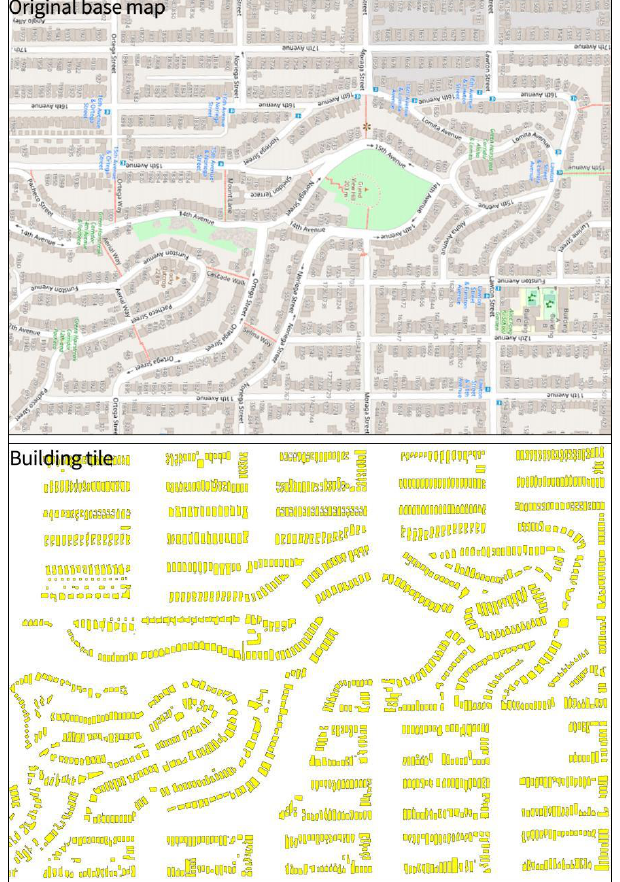
Figure 13. Experimental data.